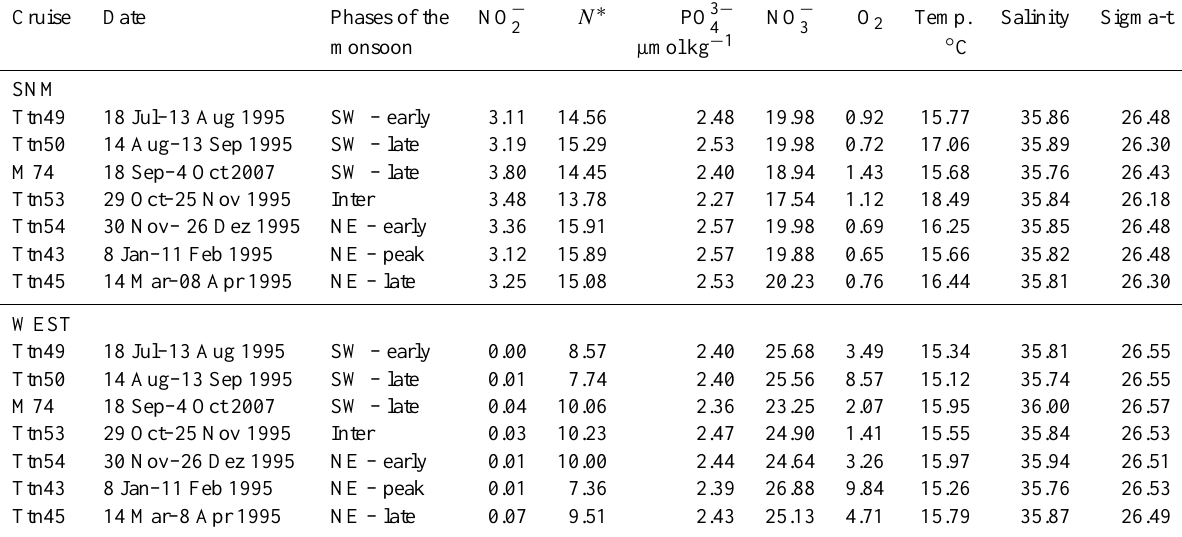
Table 1. Cruises, dates, phases of the monsoon, nutrient and oxygen concentrations, temperatures, salinities, and sigma-t, averaged for the core of the denitrifying zone SNM indicated by NO − almost the same density range in the western Arabian Sea west of 62.5 ◦ E. Only samples for which both NO − were